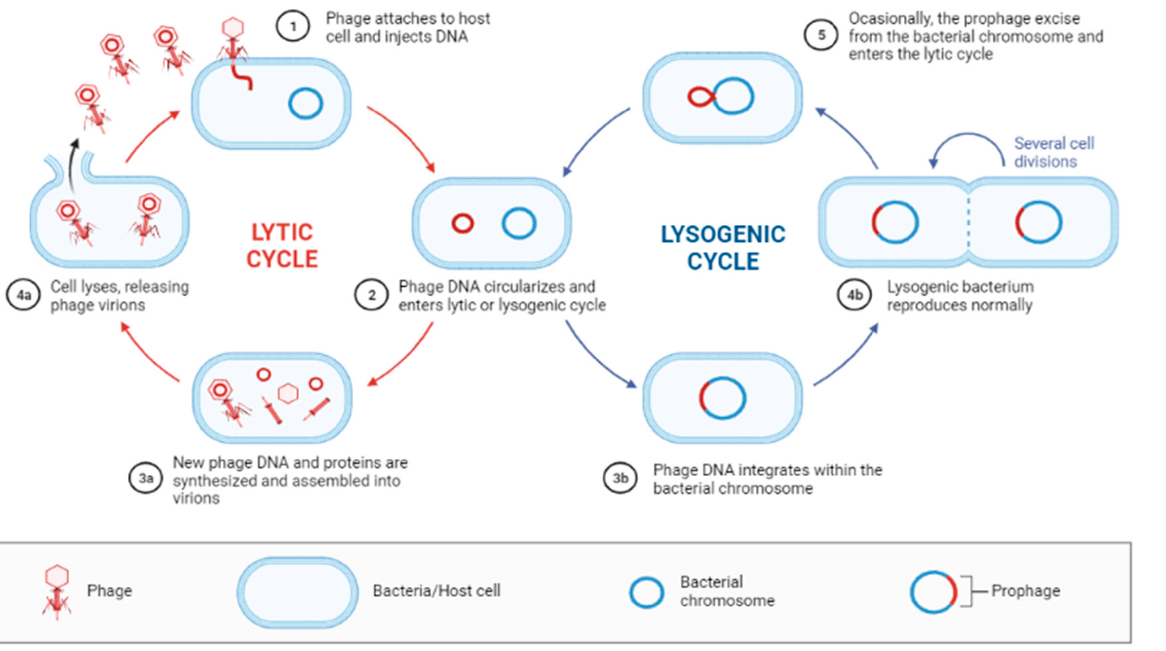
Figure 2. Lytic cycle and Lysogenic cycle. Lytic cycle: Immediately following injection into the host cell, the phage genome synthesizes early proteins that break down the host DNA, allowing the phage to take control of the cellular machinery. The phage then uses the host cell to synthesize the remaining proteins required to build new phage particles. The heads and sheaths are assembled separately, the new genetic material packed into the head and new daughter phage particles constructed. During this process, the host cells gradually become weakened by phage enzymes and eventually burst, releasing on average 100–200 new phage progeny into the surrounding environment. Lysogenic cycle: Following the injection of the phage DNA into the host cell, it integrates itself into the host genome, with the help of phage-encoded integrases, where it is then termed a prophage. The prophage genome is then replicated passively along with the host genome as the host cell divides for as long as it remains there and does not form the proteins required to produce